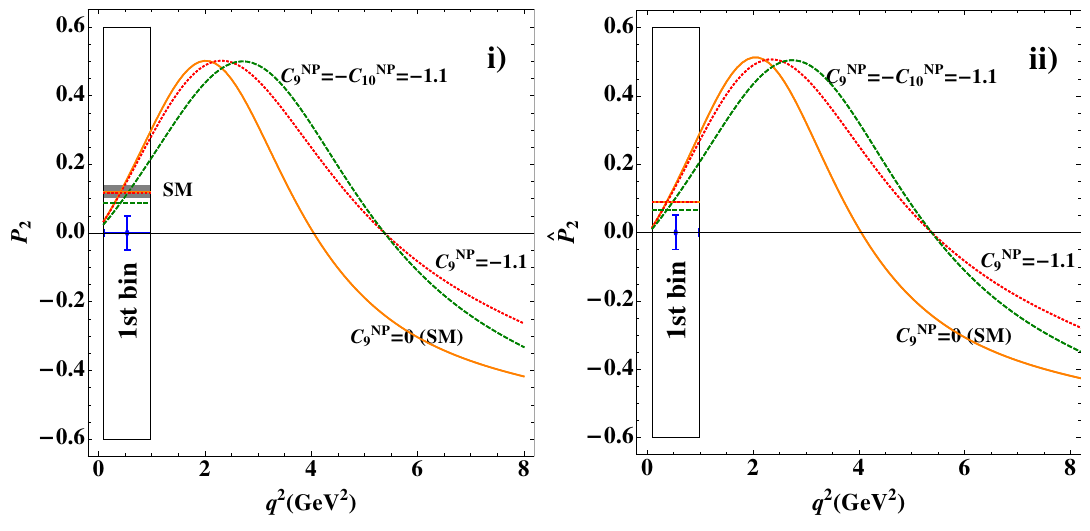
Figure 3 . i) P 2 sensitivity to NP. ii) ^ P 2 sensitivity to NP. Same conventions as (cid:12)gure